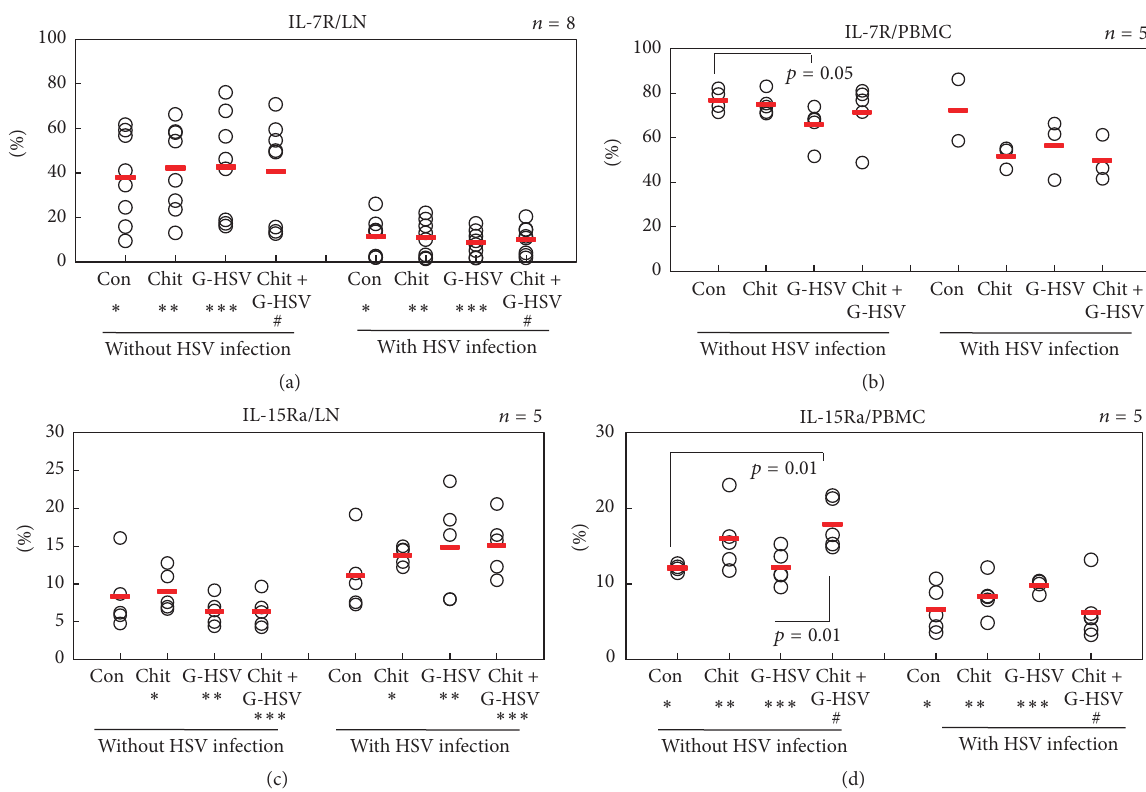
cells in LN were significantly downregulated in all four groups with HSV infection compared to those in mice without HSV infection. The frequencies of IL-15R + cells were significantly different between mice with HSV infection and those without HSV infection. The numbers of mice used in (a) were 8 and in (b), (c), and (d) were 5 in each group. In (a) ∗ 𝑝 = 0.02 , ∗∗ 𝑝 = 0.0005 , ∗∗∗ 𝑝 = 0.005 , and # 𝑝 = 0.001 . In (c) ∗ 𝑝 = 0.003 , ∗∗ 𝑝 = 0.01 , and ∗∗∗ 𝑝 = 0.001 . In (d) ∗ 𝑝 = 0.005 , ∗∗ 𝑝 = 0.005 , ∗∗∗ 𝑝 = 0.05 , and # 𝑝 = 0.0002